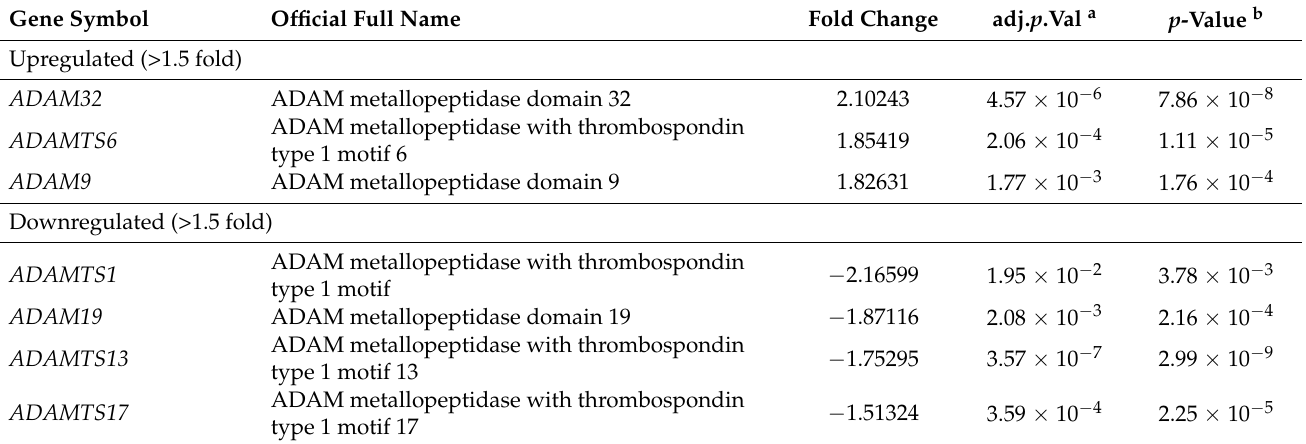
Table 1. Expression levels of ADAMs and ADAMTSs in the tumor and NCL of patients with HBL.